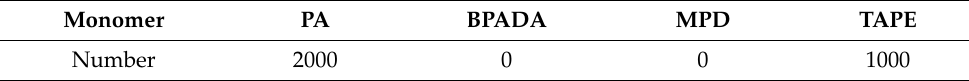
Table 1. System used for checking the way to compute the reaction rates.